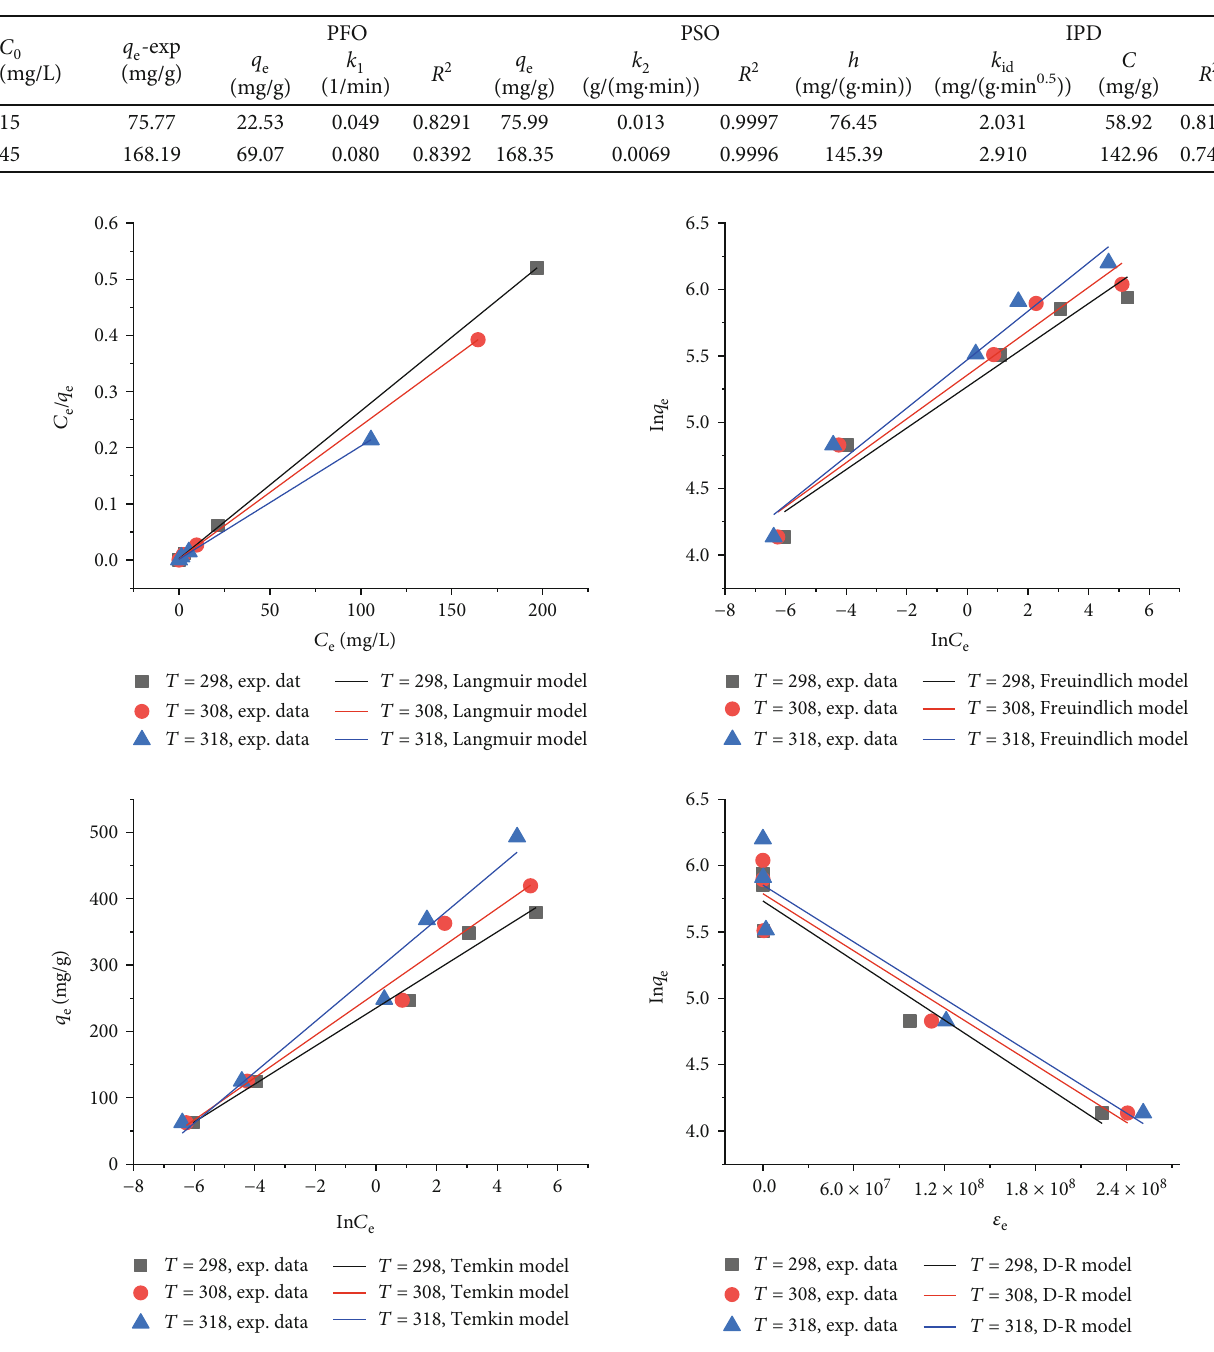
Table 2: Kinetic parameters for the adsorption of CV onto PACK.